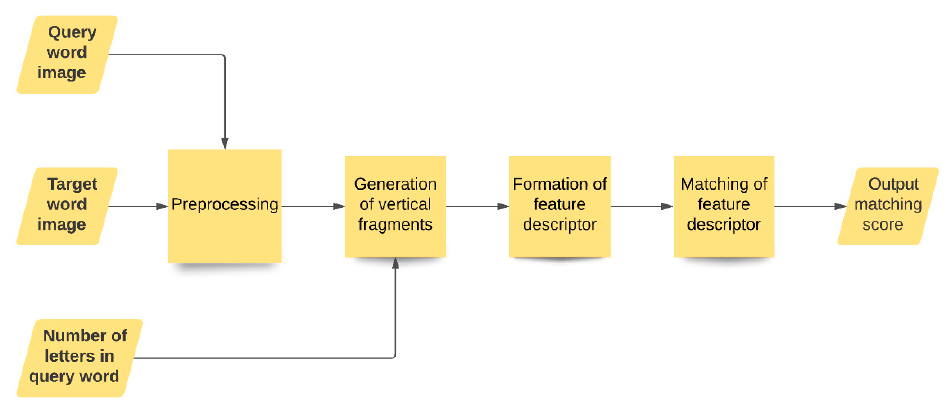
Figure 2. Block diagram showing the key modules of the proposed KWS method.